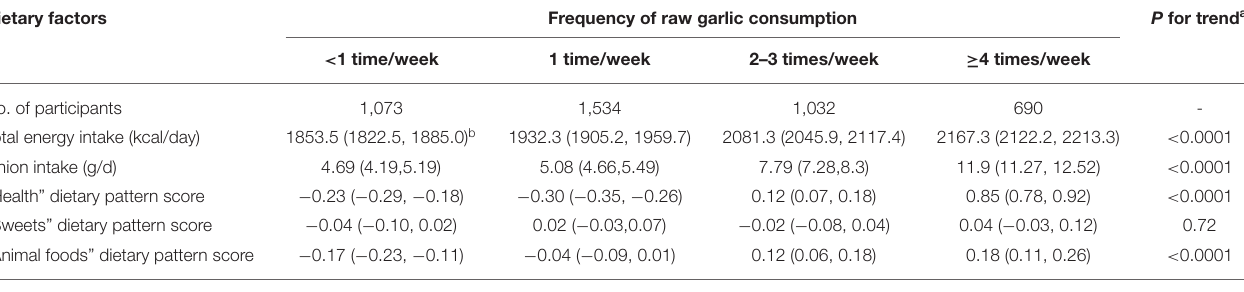
TABLE 2 | Dietary characteristics of 4,329 Chinese adults according to the frequency of garlic consumption, the Tianjin Chronic Low-grade Systemic Inflammation and Health Cohort Study 2015–2017. Dietary factors Frequency of raw garlic consumption P for trend a